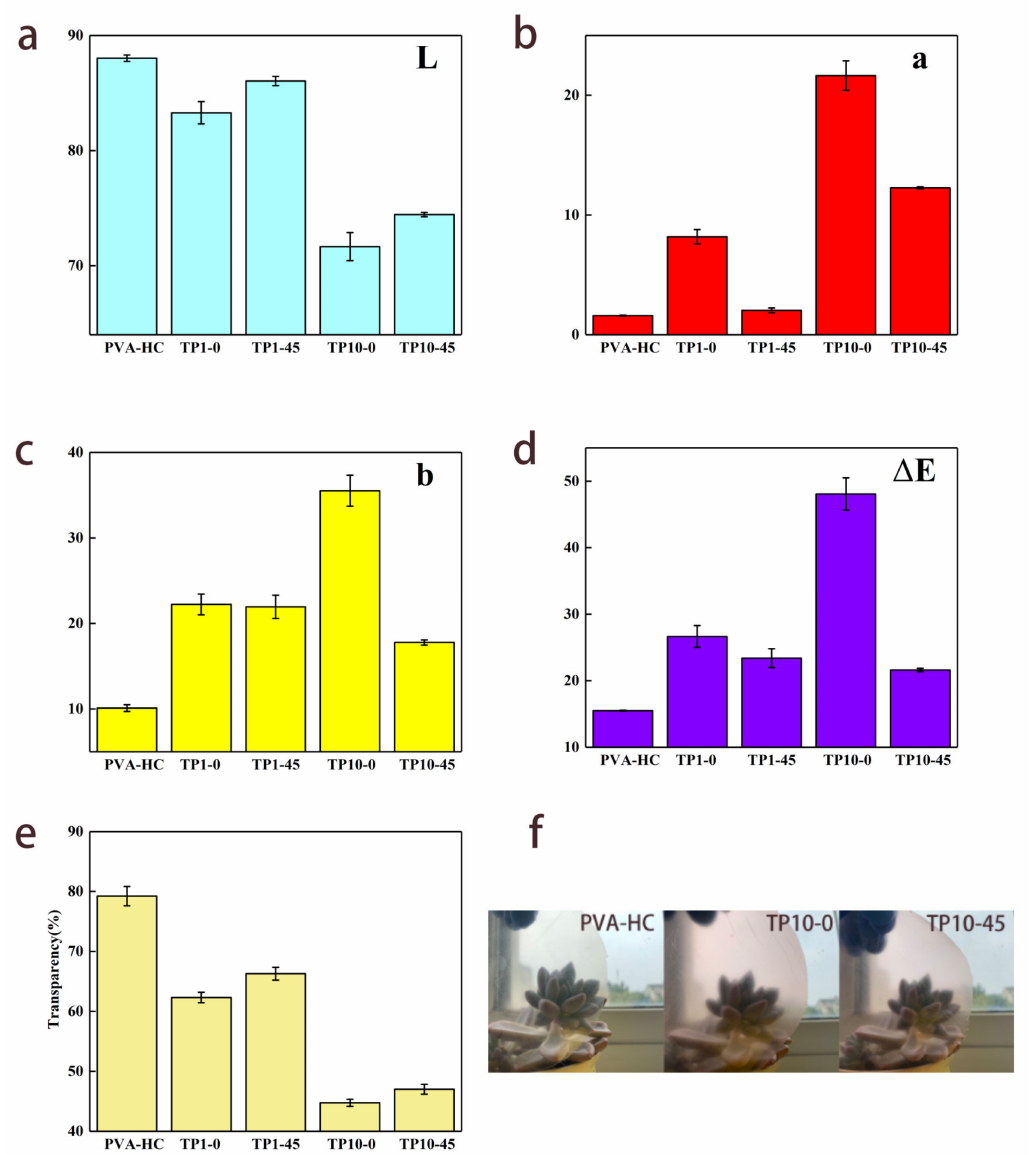
Figure 6. ( a ) L value, ( b ) a value, ( c ) b value, ( d ) ∆ E value, ( e ) transparency, and ( f ) photographs of